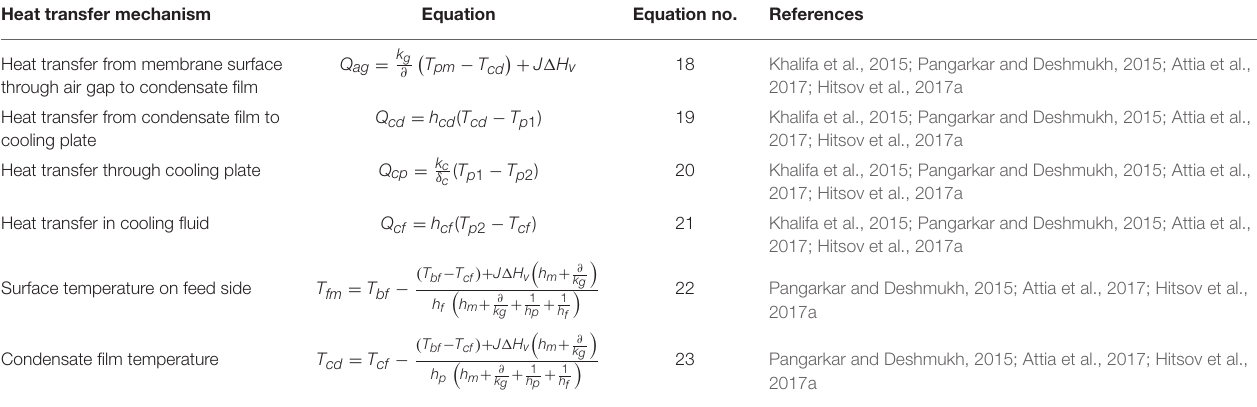
TABLE 4 | Heat transfer mechanisms for